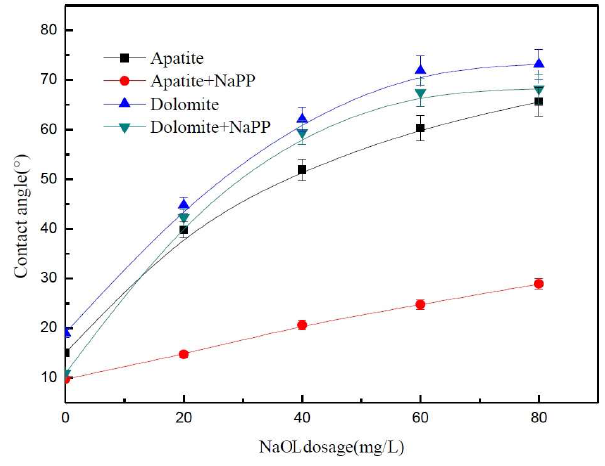
Figure 6. Contact angle of the minerals before after interaction with NaPP as a function of NaOL Figure 6.